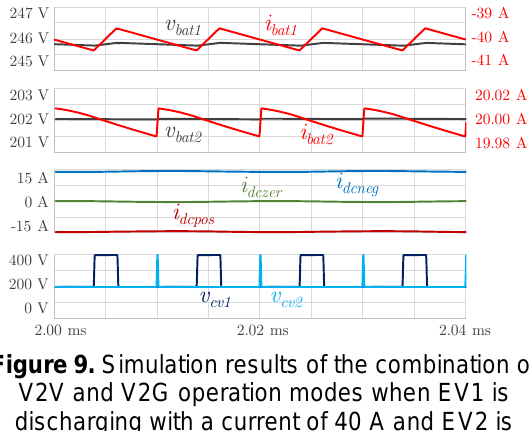
Figure 9. Simulation results of the combination of V2V and V2G operation modes when EV1 is discharging with a current of 40 A and EV2 is charging with a current of 20 A.